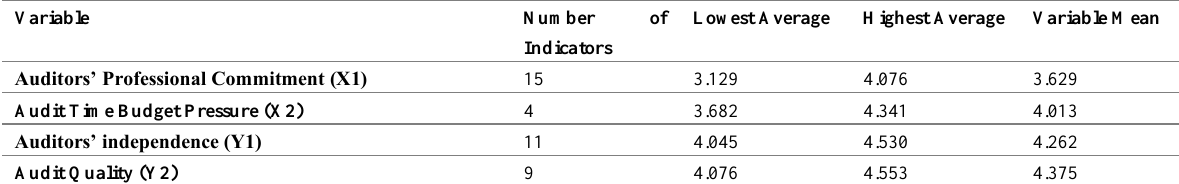
Table 3: Results Description of Respondents' Answers